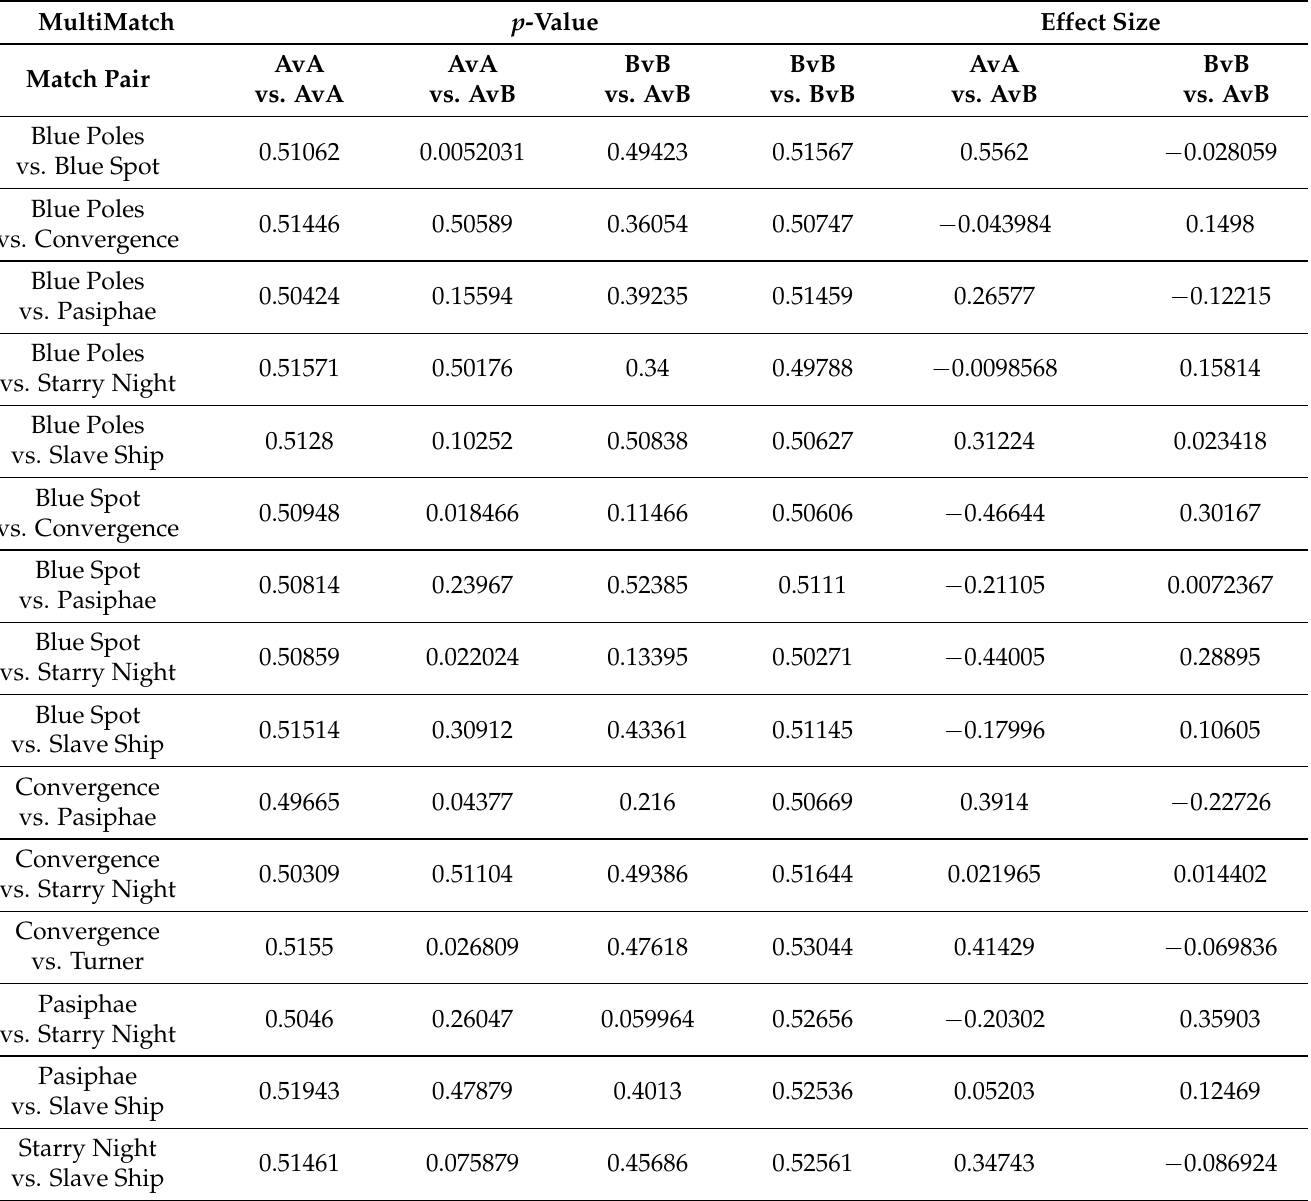
Table A6. MultiMatch position results. Match pair (e.g., Blue Poles vs. Blue Spot), where AvA, AvB, and BvB represents a match score based on a comparison of the one member of the pair with itself, or the first member of the pair ( A ) (e.g., Blue Poles) and the second member, B (e.g., Blue Spot). The effect size for (AvA vs. AvA) and (BvB vs. BvB) in all cases was